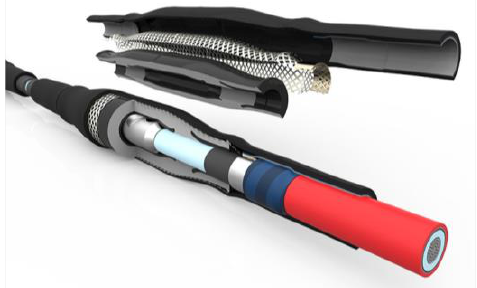
Figure 3. The internal structure of a cold-shrinkable cable joint.